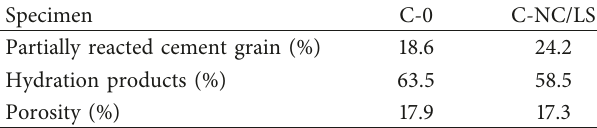
Table 3: Porosity and contents of partially reacted cement grain and hydration products calculated based on BSE results.